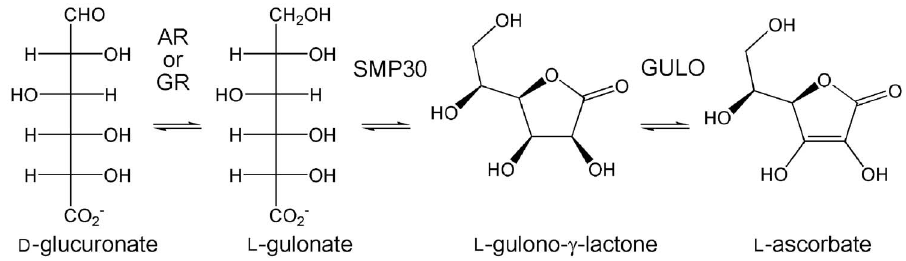
Figure 2 The final three steps of the biosynthesis of L -ascorbate from D -glucuronate. First, D -glucuronate is converted to L -gulonate by either aldose reductase (AR, 15%) or aldehyde reductase (GR, 85%) (67). SMP30 then closes L -gulonate to the five-membered lactone, L -gulono- g -lactone. In the final step, gulonolactone oxidase (GULO) converts L -gulono- g - lactone to L -ascorbate. In mammals lacking the ability to synthesize ascorbate, GULO is nonfunctional and highly